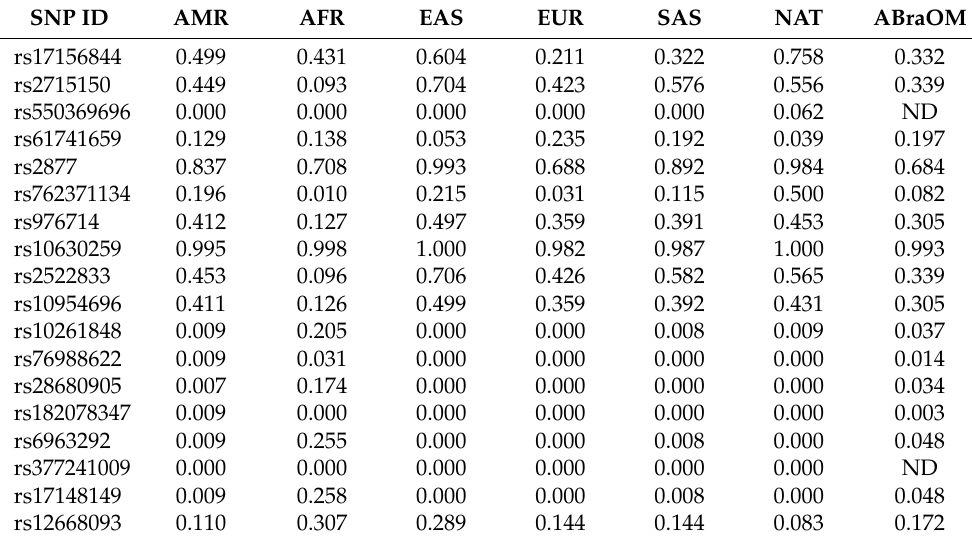
Table 3. Allele frequencies of the variants of PCLO investigated in Native American population (NAT), in the Brazilian population of Sao Paulo (ABraOM) and in African (AFR), European (EUR), American (AMR), East Asian (EAS) and South Asian (SAS) from the gnomAD Database. SNP ID